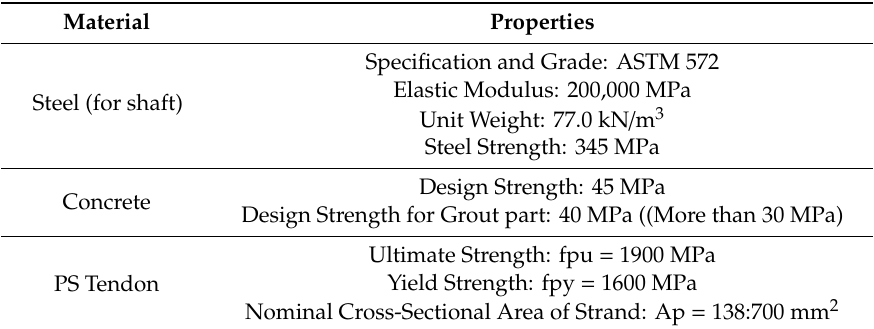
Figure 2. Dimensions of piled concrete foundation (PCF). Table 1. Material